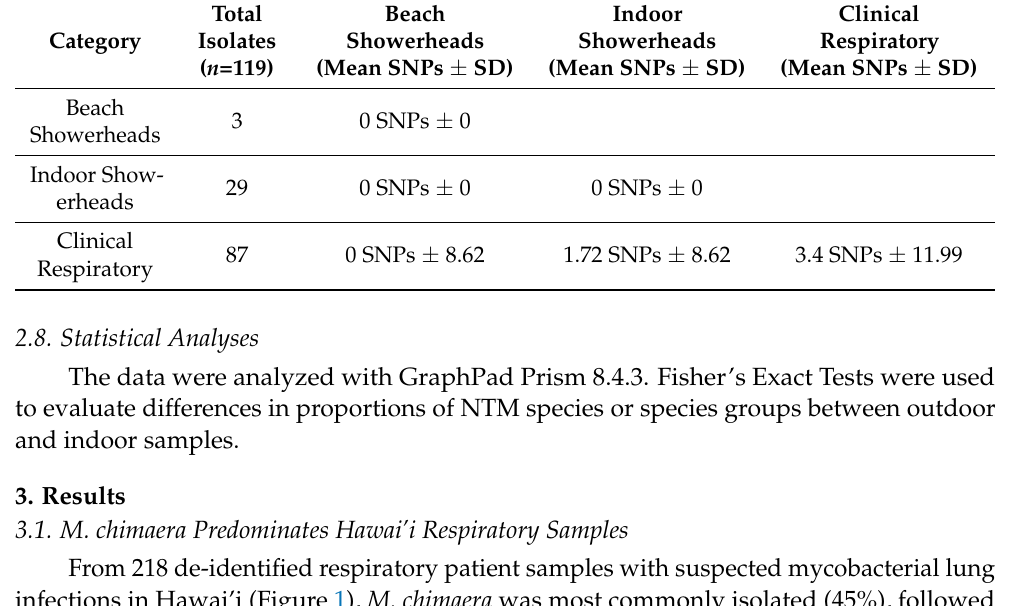
Table 2. SNP variation between rpoB sequences from 119 showerhead and clinical M. chimaera isolates.